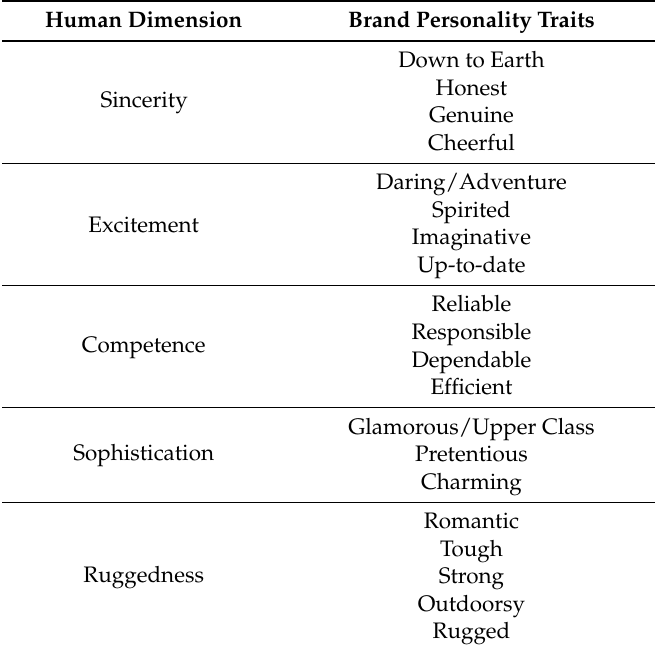
Table 1. Human Dimensions and Brand Traits (adapted from [2]). Human Dimension Brand Personality Traits Sincerity Excitement